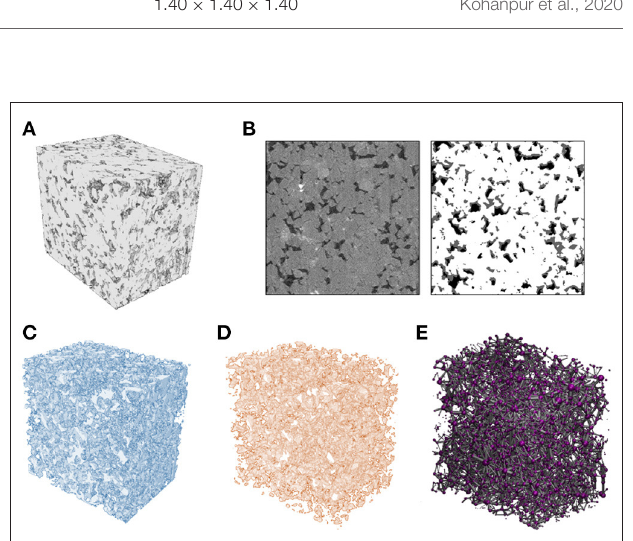
FIGURE 6 | (A) 3D representation of the Berea sandstone sample. (B) A slice of micro-CT images: left image is the raw grayscale slice and right image is the ternary segmented slice where solid part is in white, CO 2 is in black, and brine is in gray. (C) 3D representation of the pore structure. (D) 3D representation of residual trapped CO 2 after imbibition process. (E) Extracted pore-network of the Berea sandstone sample from maximal-ball